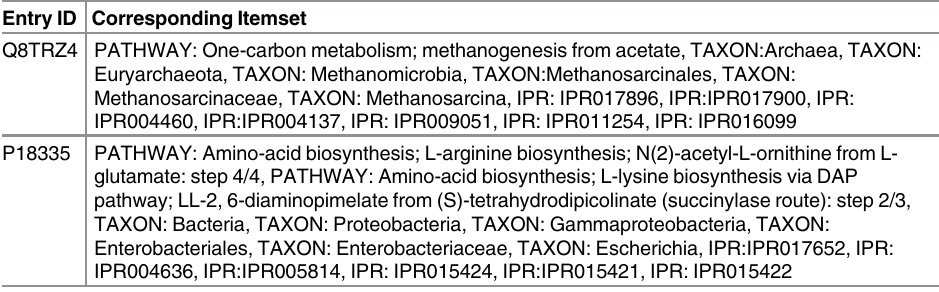
Table 3. Examples of itemsets corresponding to some UniProt/Swiss-Prot entries of some prokary- otes with manual assertion evidence for pathway annotations. Entry ID Corresponding